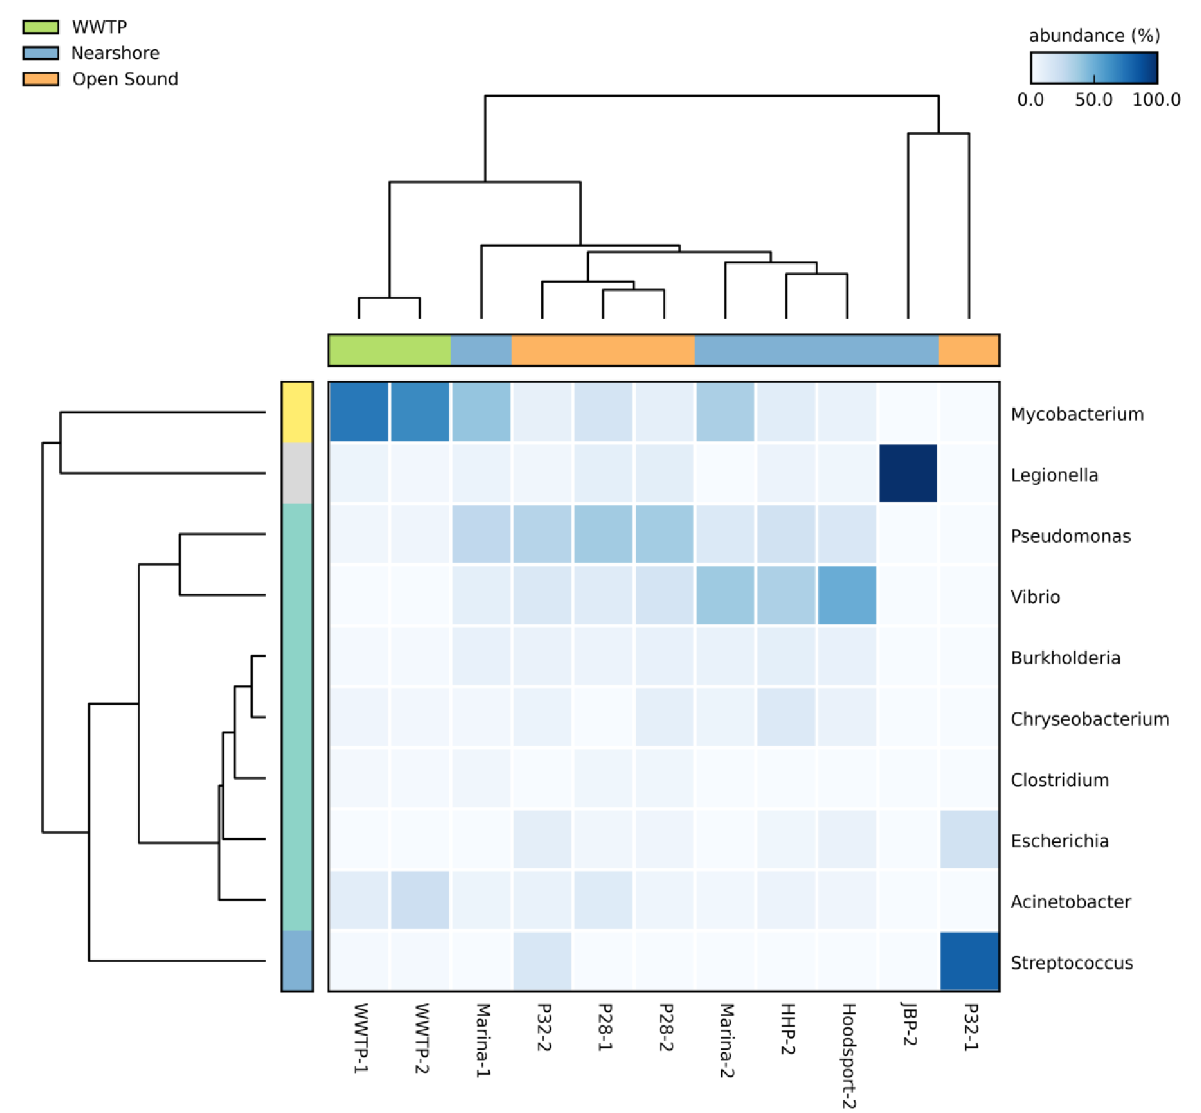
Fig 7. Relative abundances of top 10 pathogenic genera for 11 metagenomic samples. Increasing taxonomic abundance is indicated by darker blue boxes. The horizontal color bar at the top reflects sample collection location (WWTP, nearshore or open sound samples).